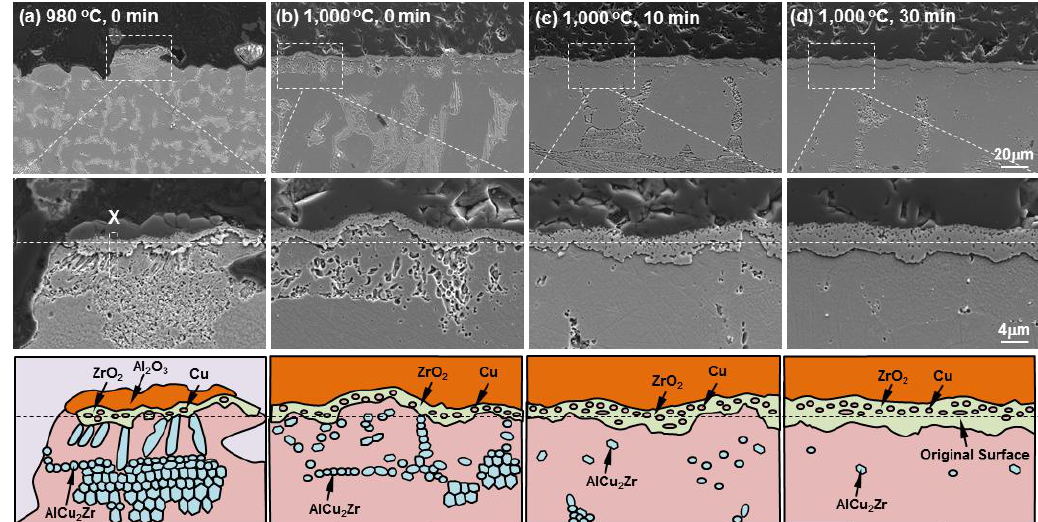
Figure 6. Secondary electron (SE) images of the reaction layers at the α-Al 2 O 3 / Cu-7Al-3.5Zr interface of the joint brazed at ( a ) 980 °C for 0 min, ( b ) 1000 °C for 0 min, ( c ) 1000 °C for 10 min, and ( d ) 1000 °C for 30 min. Magnified views of the dotted rectangles and their schematics for the microstructural characteristics are suggested below.